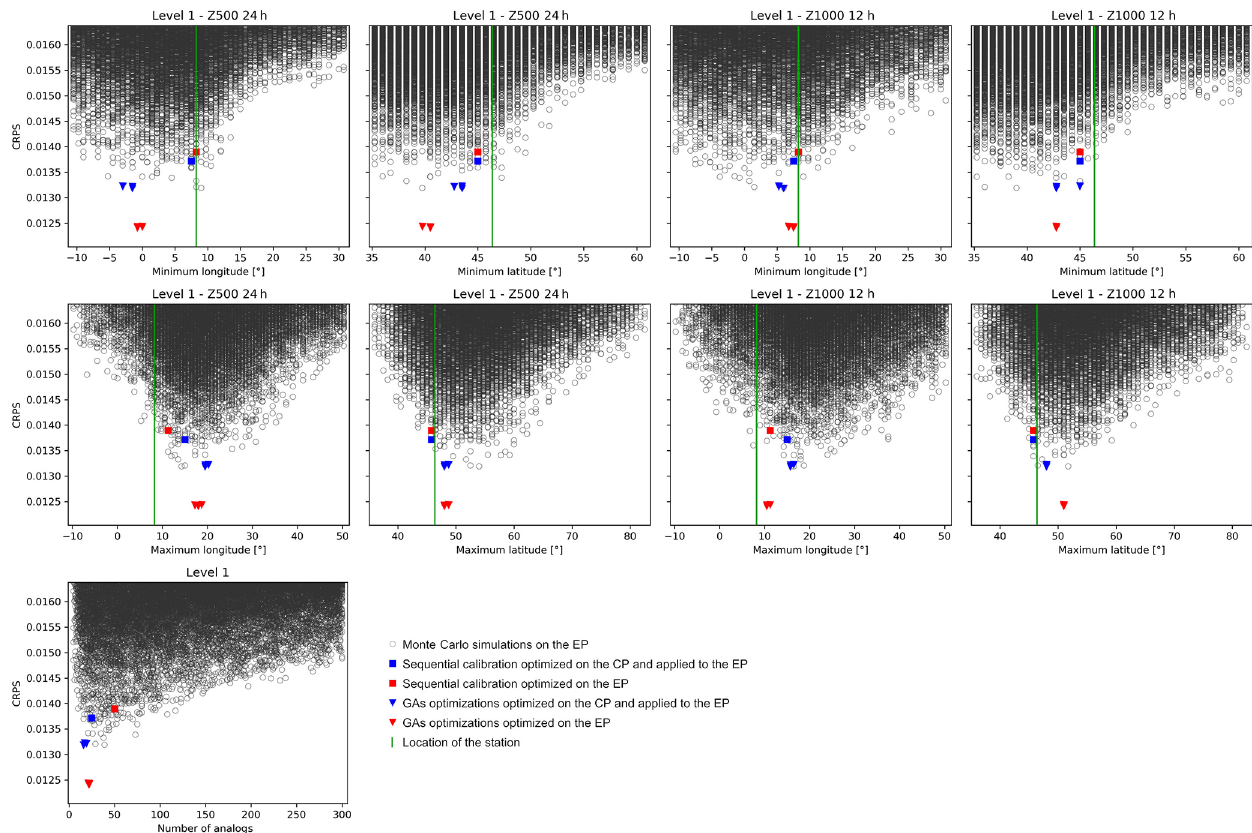
Figure 8. Example of parameter values for 2Z (Table 2) for precipitation at the Binn station (Fig. 1) on the EP. The parameters are the extent (min–max longitude–latitude) of the spatial windows for the geopotential height at 500 and 1000hPa, as well as the number of analogs. The green vertical bar in the plots represents the location of the station. The circles represent random parameters from the Monte Carlo analysis. The plots are truncated at the 25th best percentiles for 50000 realizations. Squares are the results of the sequential calibration and triangles result from genetic algorithms. Markers in blue represent parameters optimized for the CP and applied to EP. Markers in red represent parameters optimized for the